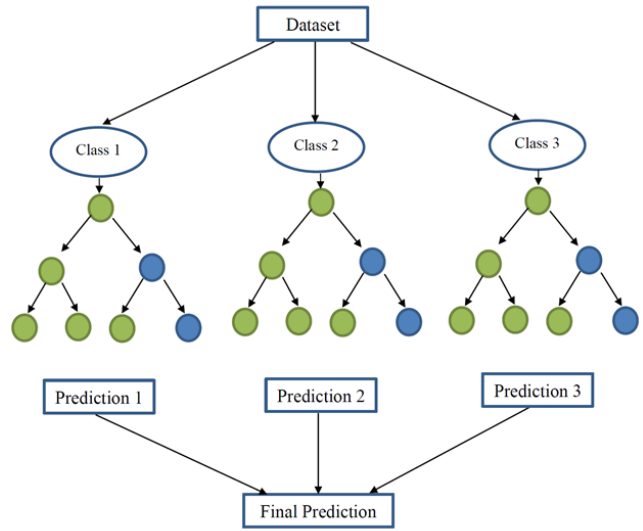
Figure 3. A pictorial view of the random forest working